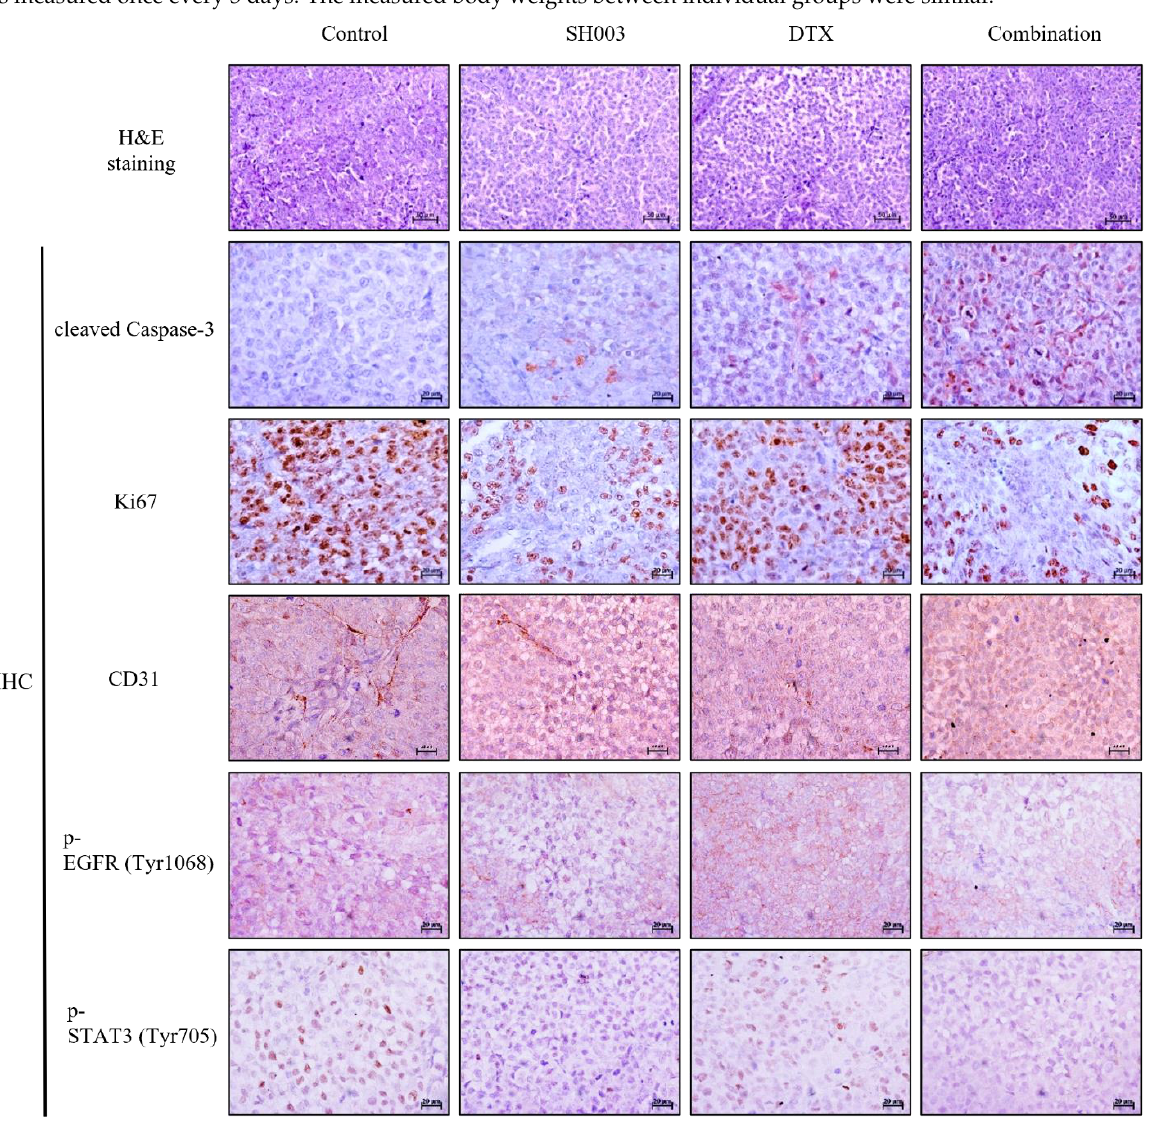
Figure 5. Immunohistochemical analysis of tumors treated with SH003 and docetaxel from H460 xenograft mouse model. Paraffin-embedded tumor sections were characterized by hematoxylin and eosin staining (scale bar, 50 µm) and immuno- histochemistry for cleaved caspase-3, Ki-67, CD31, p-EGFR (Y1068) and p-STAT3 (Y705). Scale bar, 100 µm. These are representative images. STAT, signal transducer and activator of transcription. Table 2. Information of human equivalent dose. Animal equivalent dose was calculated using the